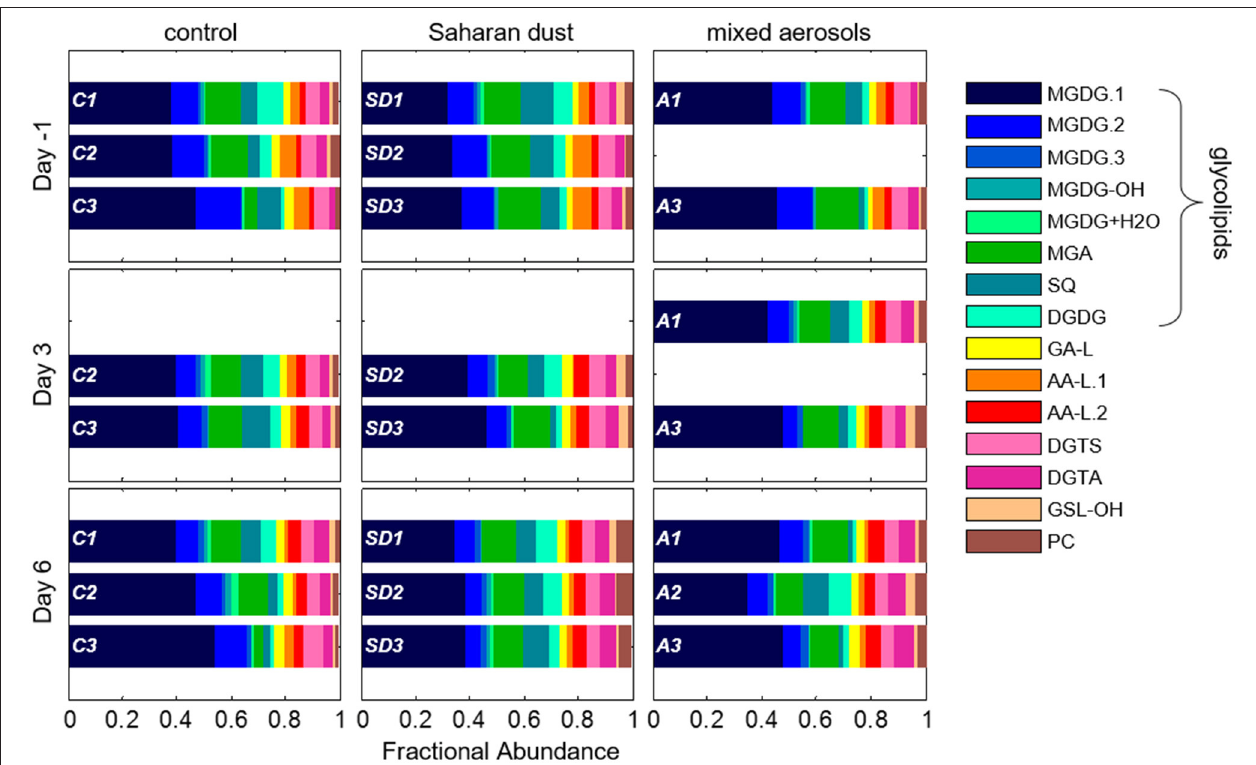
FIGURE 3 | Relative distribution of IPLs in replicate mesocosms of the control (C), Saharan dust (SD), and mixed aerosol (A) experiments on each sampling day. Data for each replicate mesocosm are shown as one barplot in each panel in consistent order.